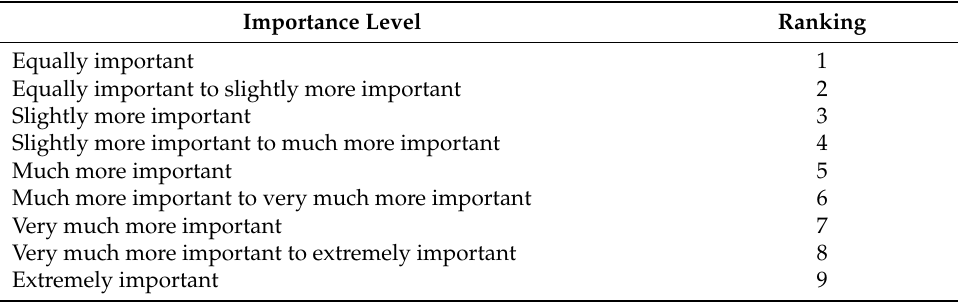
Table 4. Fundamental scale of absolute numbers used in the questionnaire (Saaty,